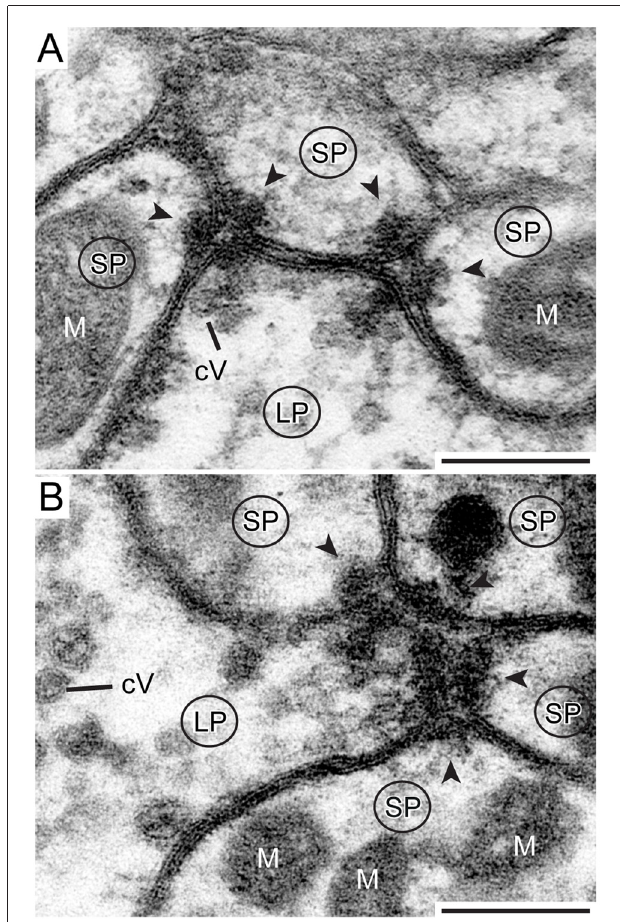
FIGURE 7 | Detailed view of two types of synapse. (A) One presynaptic LP of a TuLAL1 neuron (LP) gives input into three small postsynaptic profiles (SP) of a TL neuron via two divergent dyads. The structure of both dyads is similar: some small cVs are near an electron dense stalk-like structure at the presynaptic membrane. The synaptic cleft between the pre- and postsynaptic membranes has a triangular structure. In both postsynaptic profiles the membranes form electron dense foldings due to transmitter receptors (arrowheads) and contain mitochondria (M). (B) One presynaptic terminal (LP) and four postsynaptic profiles (SP) forming a divergent tetrad. Many small cVs are concentrated at the presynaptic membrane. Scale bars = 200